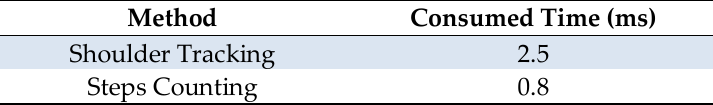
Table 1. Computational cost of each step in the proposed